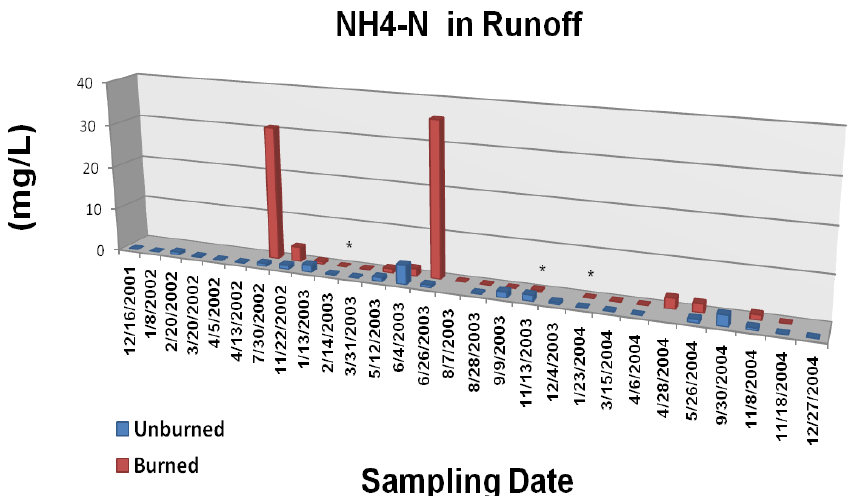
Figure 6A. Mean ammonium N concentrations in overland/litter interflow runoff from unburned and wildfire burned study plots. The Gondola wildfire occurred 3 July, 2002. Significant differences are noted as p < 0.10 (*), p < 0.05 (**), or p < 0.01 (***). Adapted from [22].